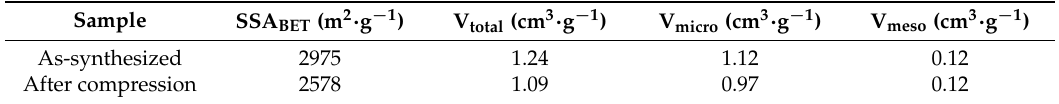
Table 6. BET surface area, total porous volume, micro- and mesoporous volumes of KUPO16-2-750 before and after the tablet formation (pressing at 15 tons/cm 2 for 10 min).